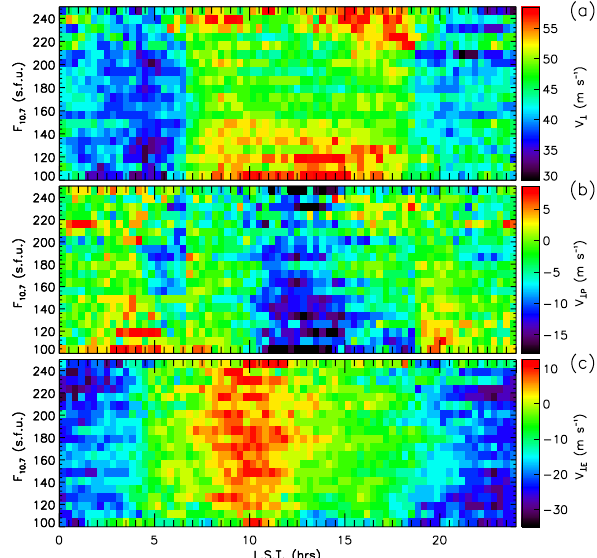
Fig. 6. Colour map showing the variation of (a) velocity magnitudes V ⊥ , (b) V ⊥ P , and (c) V ⊥ E with LST and 10.7-cm solar flux for the entire 5-year database. The averages were calculated using bin sizes of 20min in LST and 8 × 10 − 22 Wm − 2 Hz − 1 in solar flux. Note that 1s.f.u.=10 − 22 Js − 1 m − 2 Hz − 1